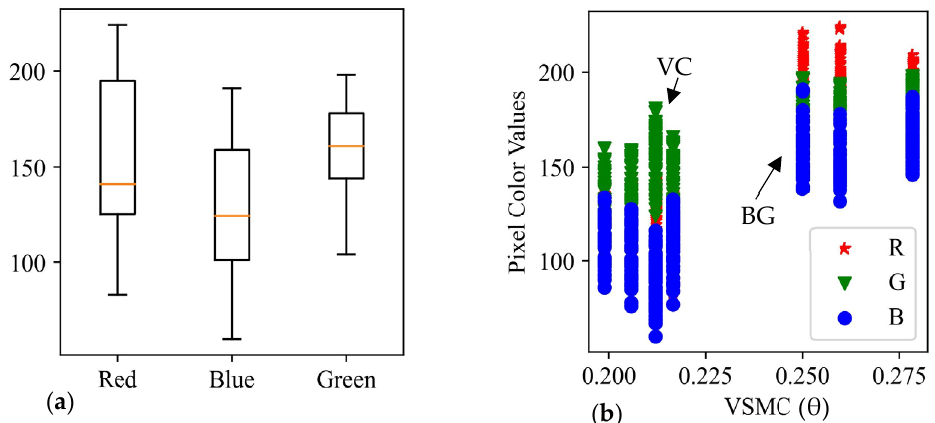
Figure 8. Cleaned-up dataset visualization. ( a ) RGB boxplots. ( b ) Vegetation vs. bare ground RGB data distribution.